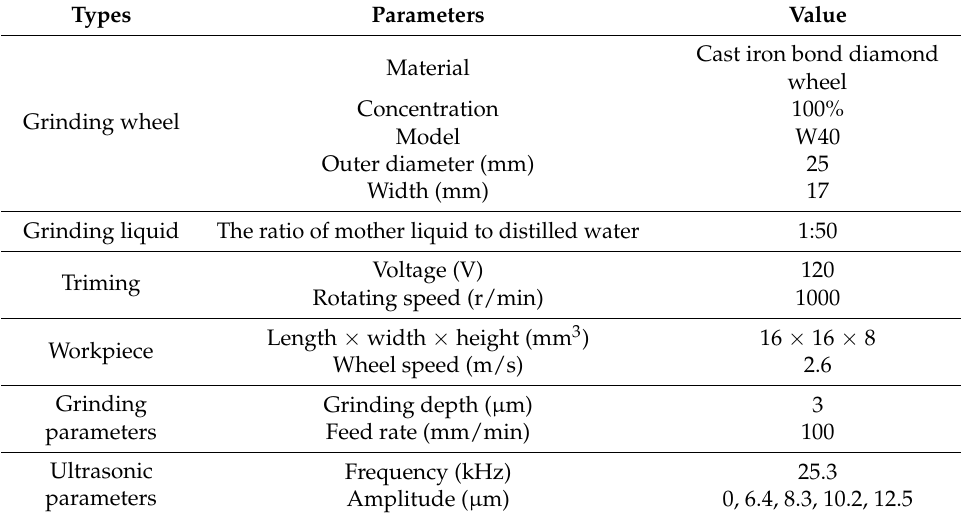
Table 1. Relevant parameters during grinding.